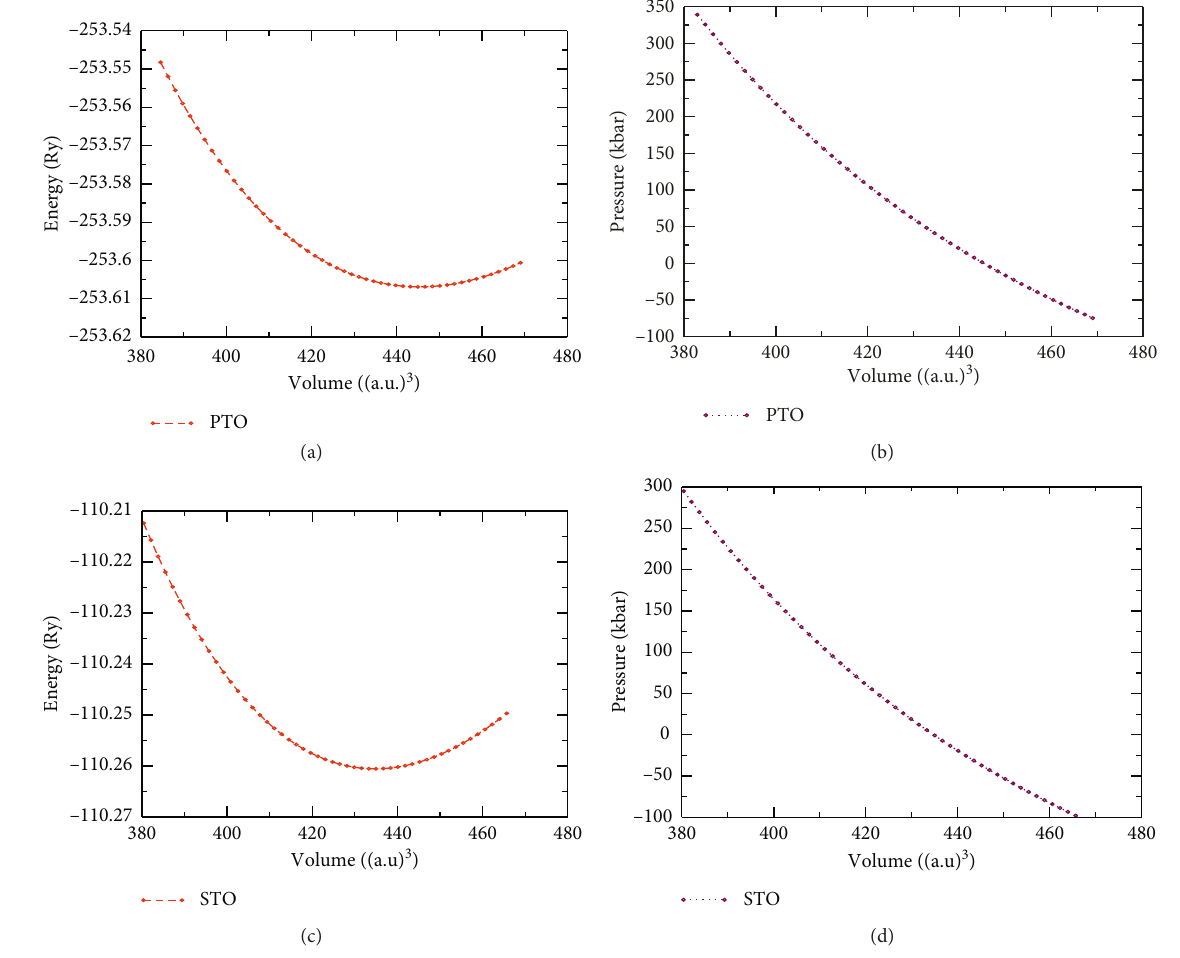
Figure 3: Variation of energy and pressure with respect to volume.